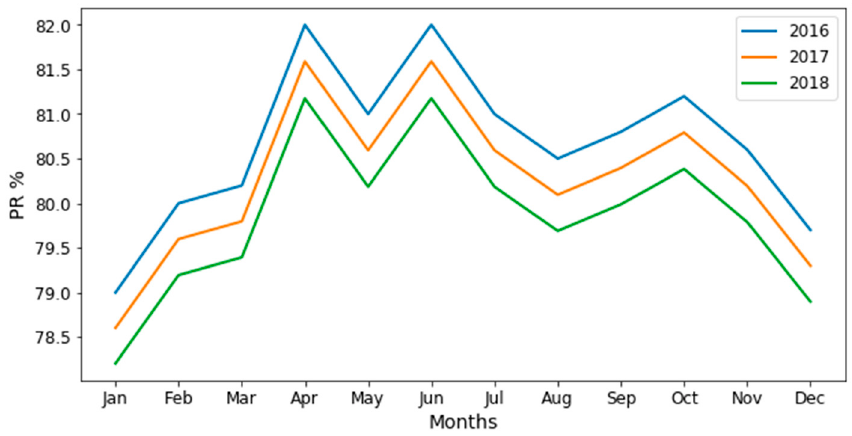
Figure 13. Estimated performance ratio of a-Si PV system.